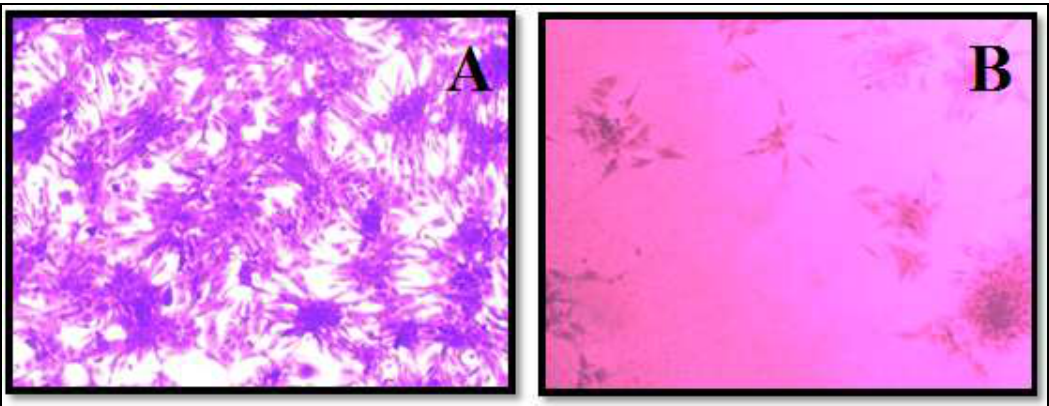
Figure 6. Morphology of AMJ13 cell A: before treatment, B: After